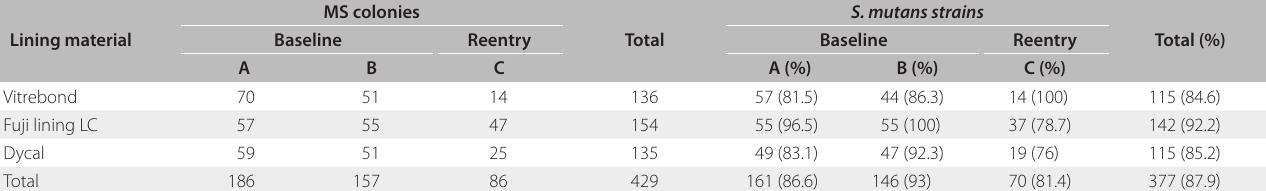
Table 1. MS colonies isolated from SB-20 medium and S. mutans strains identified by